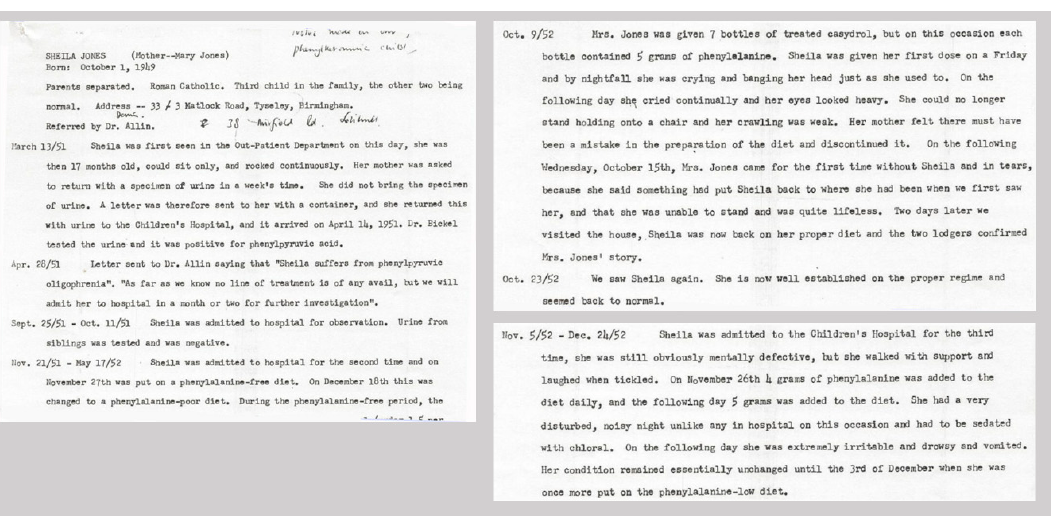
Figure 1. Three fragments of the original patient notes on the first phenylketonuria (PKU) patient treated, Sheila Jones. (Editorial note: as the name of this famous patient and her history are universally